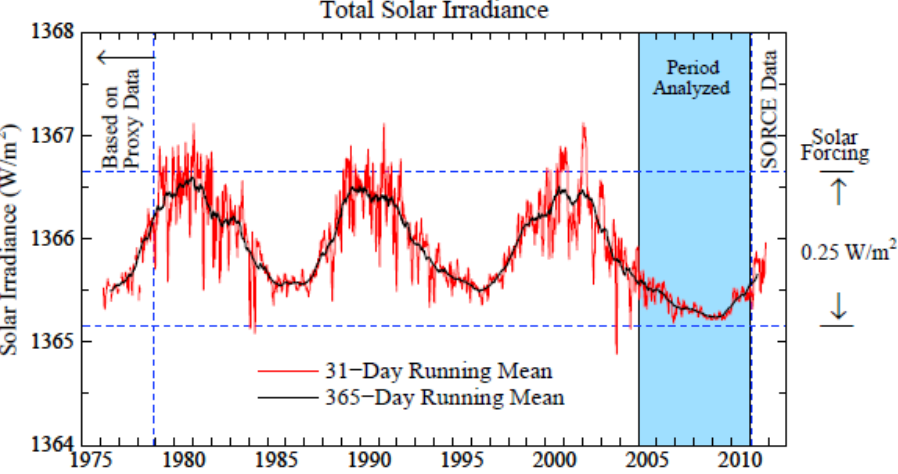
Fig. 17. Solar irradiance from composite of several satellite-measured time series. Data through 2 February 2011 is from Frohlich and Lean (1998 and Physikalisch Meteorologisches Observatorium Davos, World Radiation Center). Update in 2011 (through 24 August) is from University of Colorado Solar Radiation & Climate Experiment normalized to match means over the final 12 months of the Frohlich and Lean data. Recent estimates of mean solar irradiance (Kopp and Lean, 2011) are smaller, 1360.8 ± 0.5Wm − 2 , but the uncertainty of the absolute value has no significant effect on the solar forcing, which depends on the temporal change of